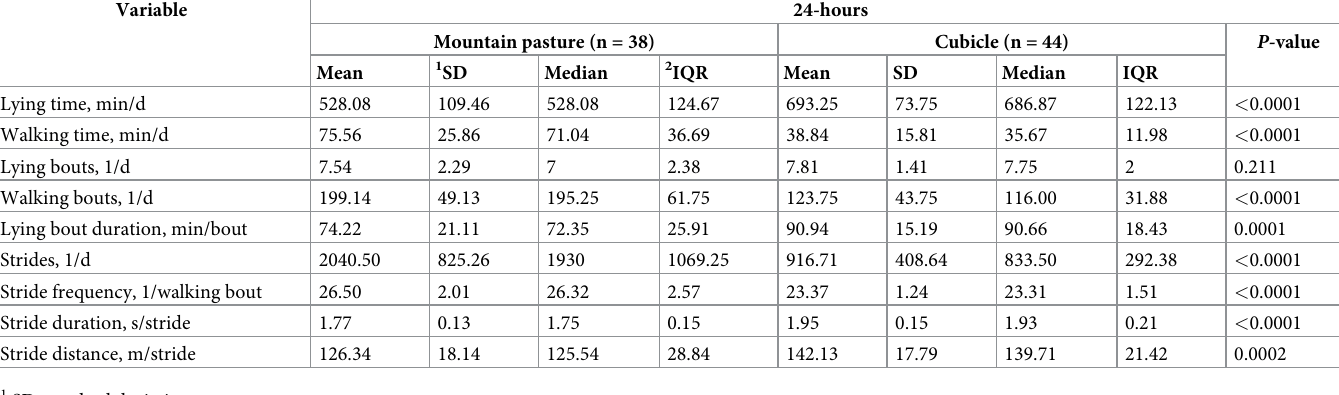
Table 2. Comparison of RumiWatch 1 accelerometer variables of mountain pasture and cubicle housing cows during 24-hour locomotion activity budget.